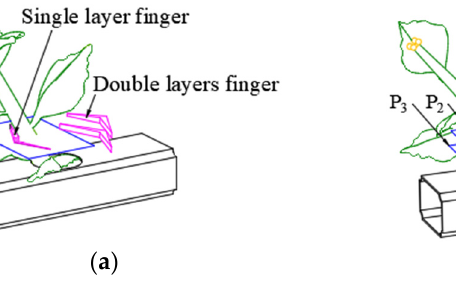
hydroponic Chinese kale at P 1 and P 2 , and F P and F P also form a torque on the grabbable 2 1 area to rotate stalk of the kale toward the centerline of the planting hole. Through the contact of the different layers, the V-shaped cross fingers could exert rotational constraints around the X g and Y g axes on the grabbable area of the kale. The two opened V-shaped fingers would first reach outside the planting hole to keep the grasping center consistent with the center of the planting hole and then grasp gradually to enclose the hydroponic Chinese kale in any position and orientation to the center of the planting